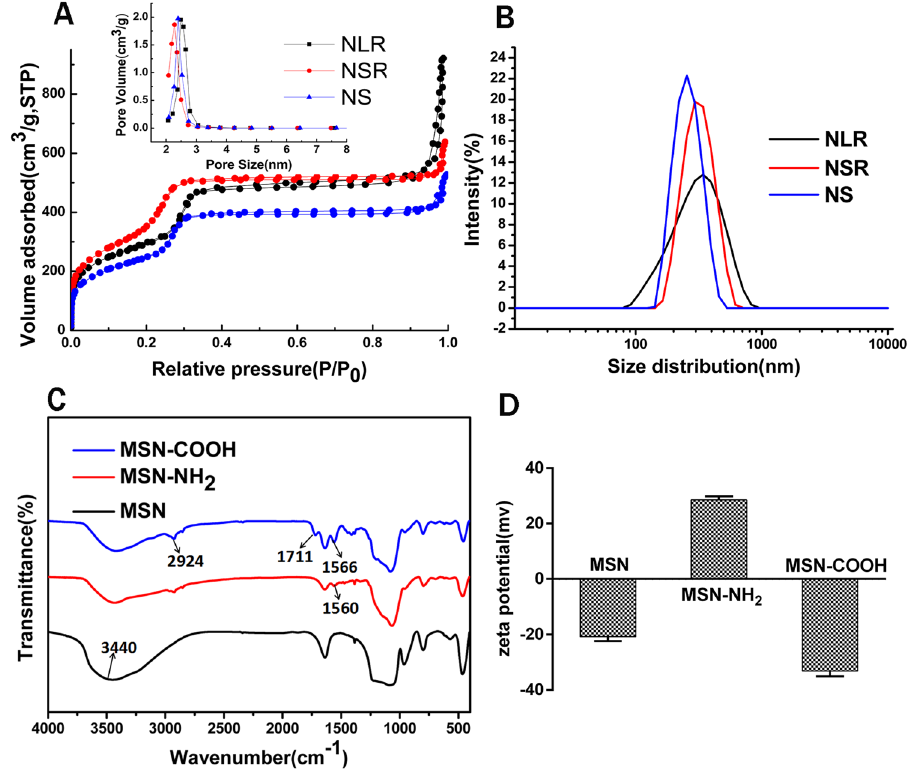
Figure 2. ( A ) Nitrogen adsorption/desorption isotherms and pore size distribution of NLR, NSR and NS. ( B ) Size distribution of NLR, NSR and NS. ( C ) FTIR spectra and ( D ) zeta potentials of MSNs, MSN-NH 2 , MSN- COOH.